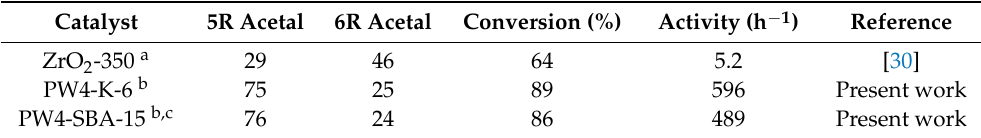
Table 4. Comparison of the results for acetalization of glycerol with literature data for other solid acid catalysts. Catalyst 5R Acetal 6R Acetal Conversion (%) Activity (h − 1 ) Reference ZrO 2 -350 a 29 46 64 5.2 [30] PW4-K-6 b 75 25 89 596 Present work PW4-SBA-15 b,c 76 24 86 489 Present